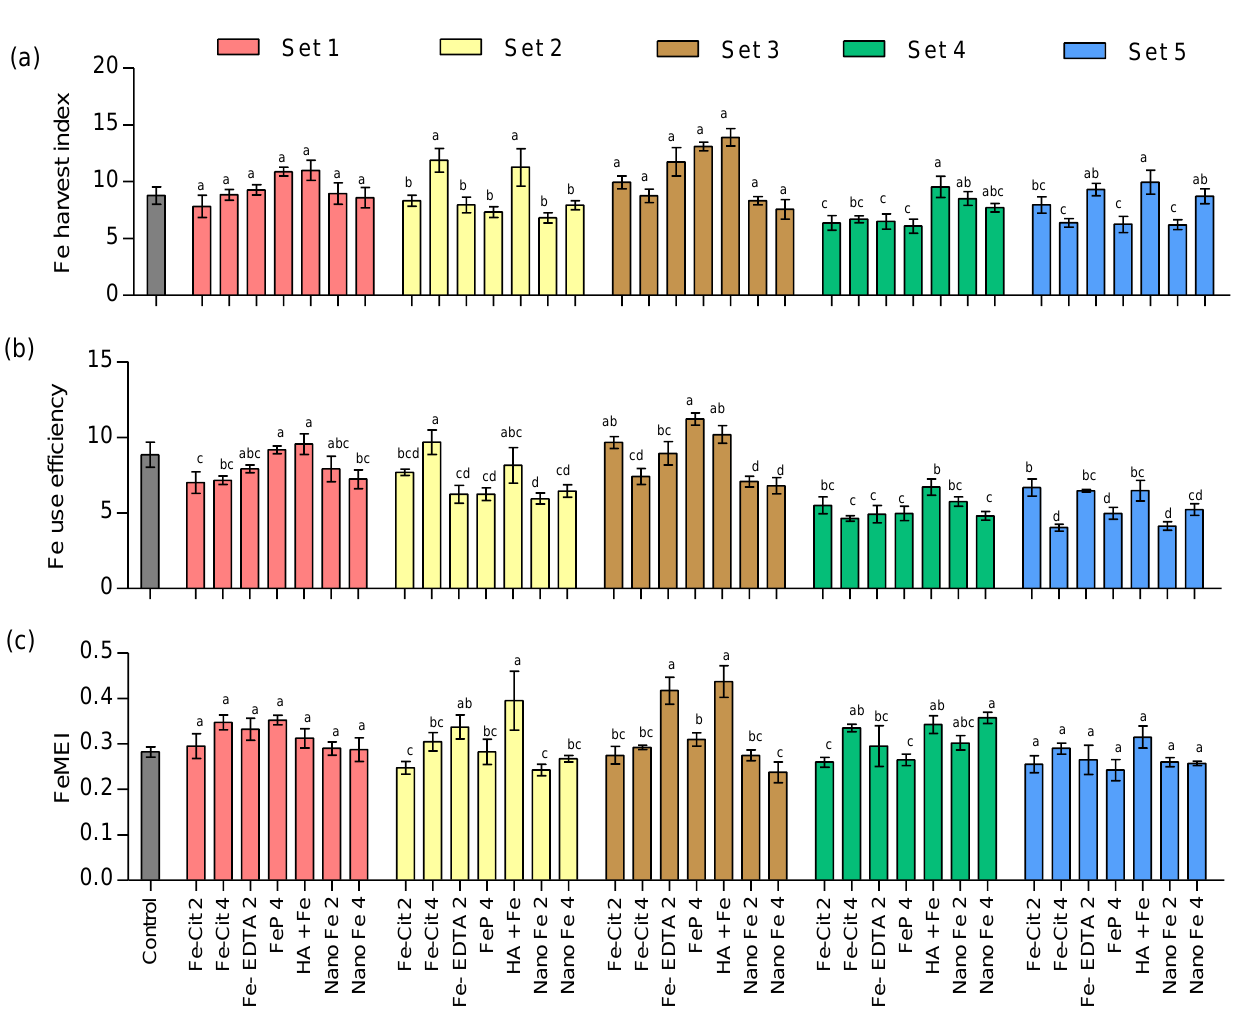
Figure 8. Influence of foliar application of Fe compounds on Fe indices in rice: ( a ) Fe harvest index, ( b ) Fe use efficiency, and ( c ) Fe mobilization efficiency index (FeMEI). Data correspond to means ± SEm ( n = 5). The plants of set 1, set 2, and set 3 received single sprays in the tillering, anthesis, and grain-filling stages, respectively, while set 4 plants were sprayed twice (anthesis and grain-filling stages) and set 5 plants were sprayed in all three growth stages. Each set was analyzed separately using a one-way ANOVA, and the least significant difference was calculated. Means with same letter were not significantly different at p < 0.05. Details of the two-way ANOVA are presented in Table